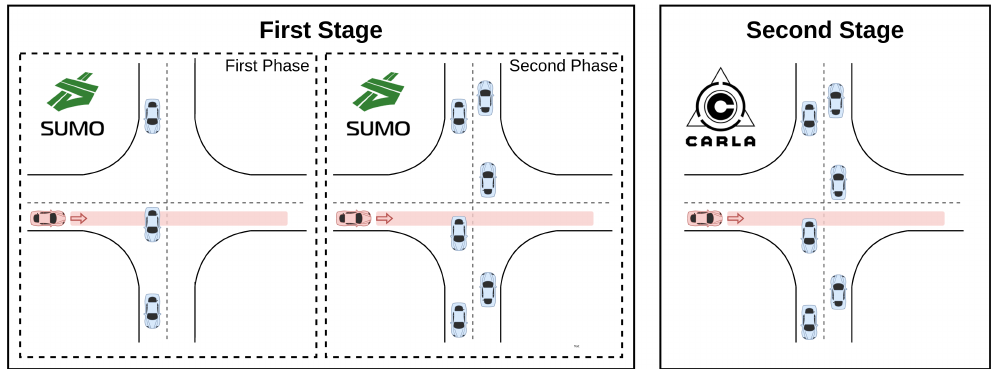
Figure 6. Training methodology: The first stage in SUMO with two phases of increasing complexity and the second stage in